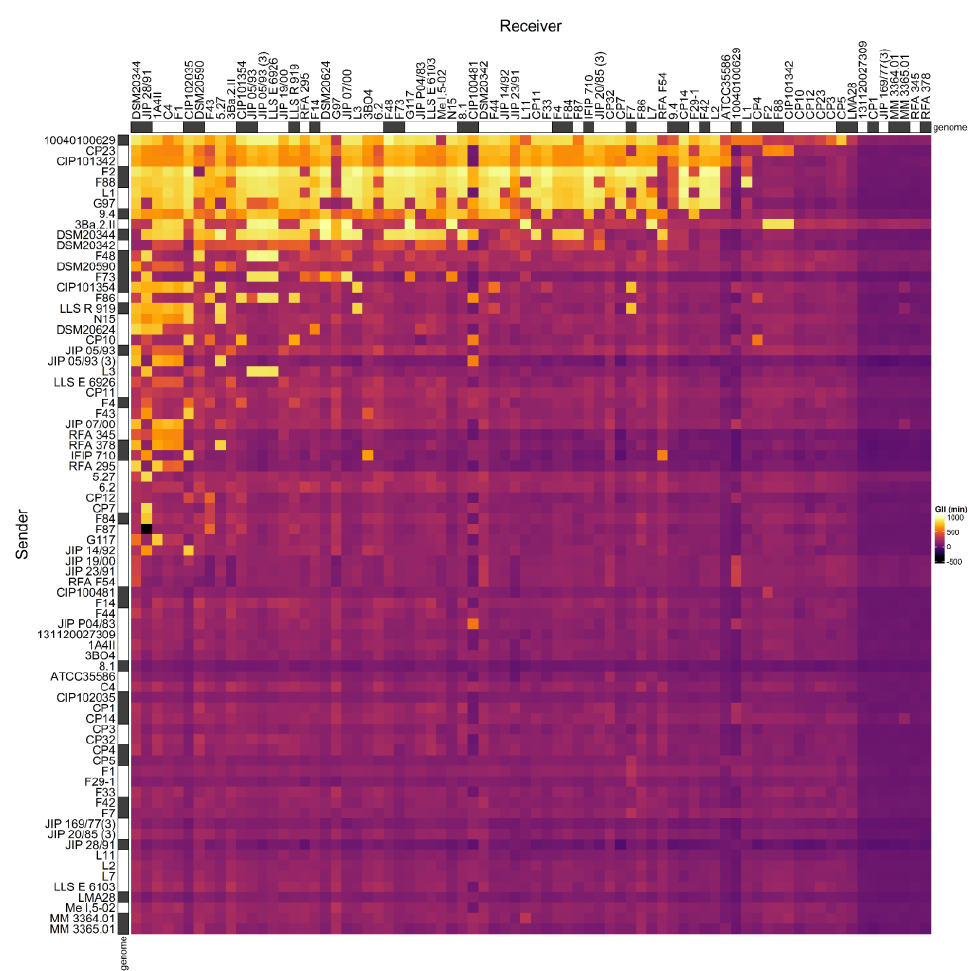
Figure 1. Adjacency matrix representing the GII inhibition values resulting from pairwise competition assays in C. maltaromaticum . The matrix was constructed with the data produced for 73 strains by [33] and the three additional strains C. maltaromaticum 10040100629, 3Ba.2.II, and DSM20590. The supernatant of sender strains (in rows) was added to cultures of the receiver strains (in columns) in order to measure their impact on the growth of the receivers. The color scale from purple to yellow represents increasing GII values. On the X -axis the strains are sorted in the descending order of sender degree from the left to the right. On the Y -axis, the strains are sorted in descending order of receiver degree, from the top to the bottom. The strains for which the genome was analyzed in this study are indicated with a grey box next to the name of the strains.